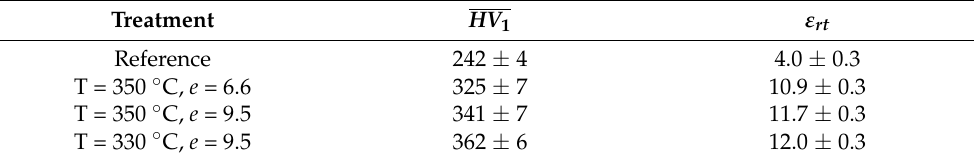
Table 2. Hardness and total maximum completely recoverable strain of NiTi SMA. Treatment HV 1 ε rt